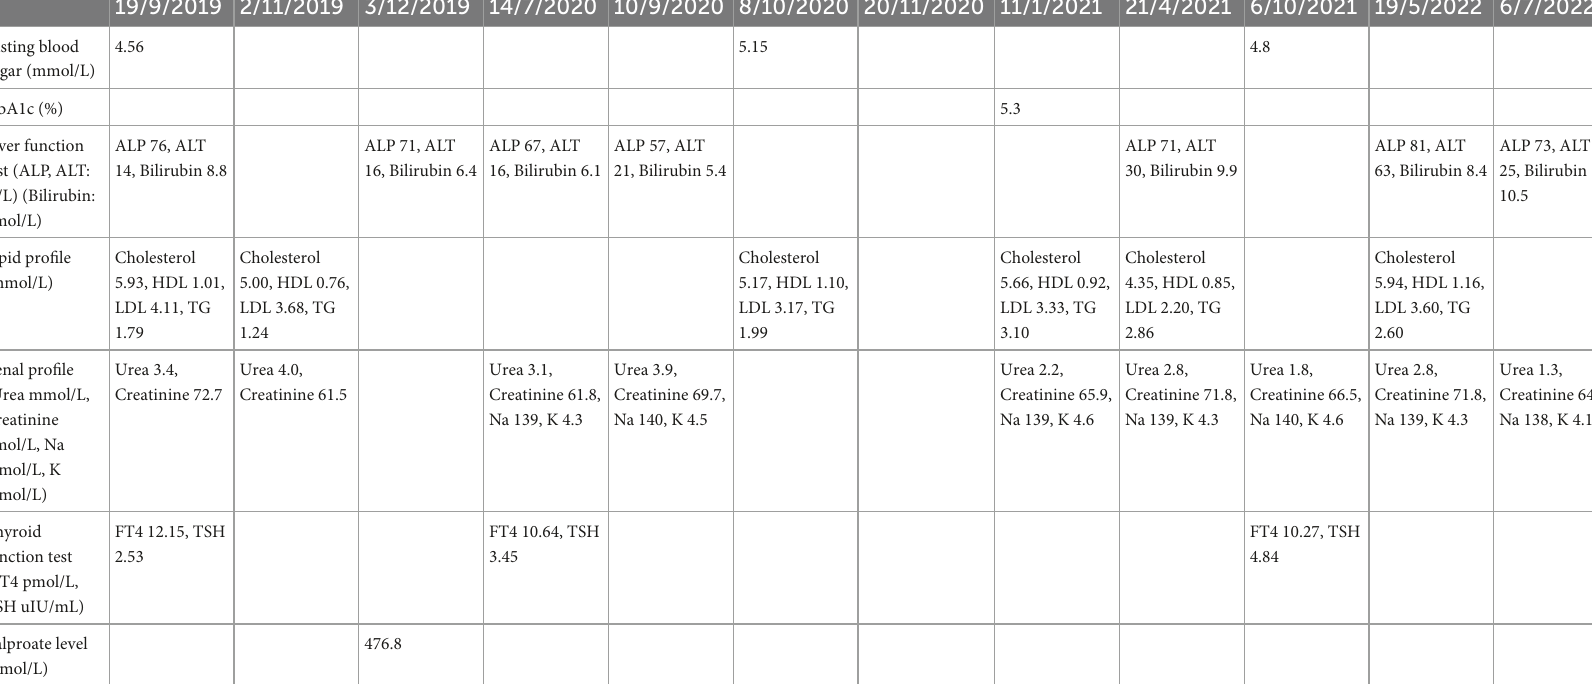
TABLE 1 Summary of